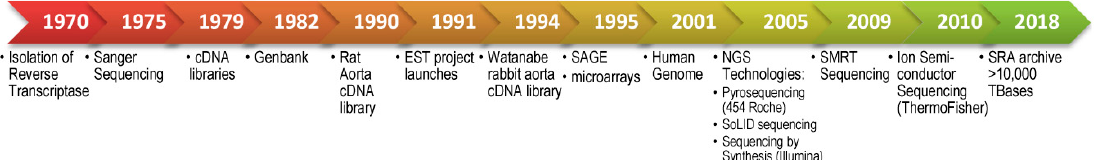
Figure 2. Timeline of the introduction of prominent technologies for gene expression measurement